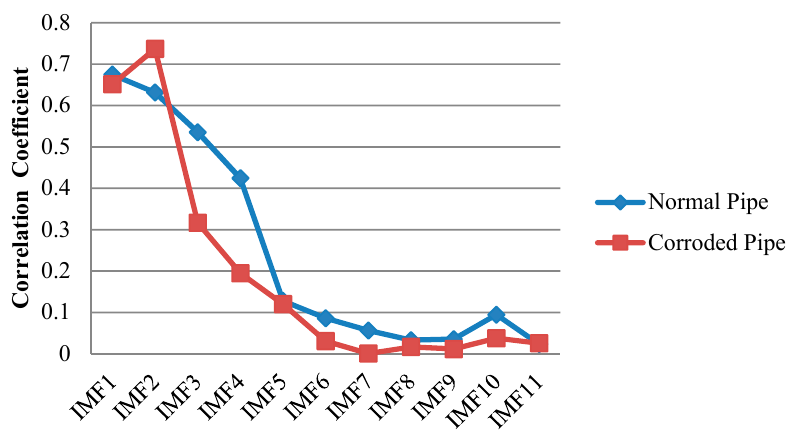
Figure 20. Absolute cross correlation of guided wave signals from the pipes in residential building with their corresponding IMFs obtained from EEMD.